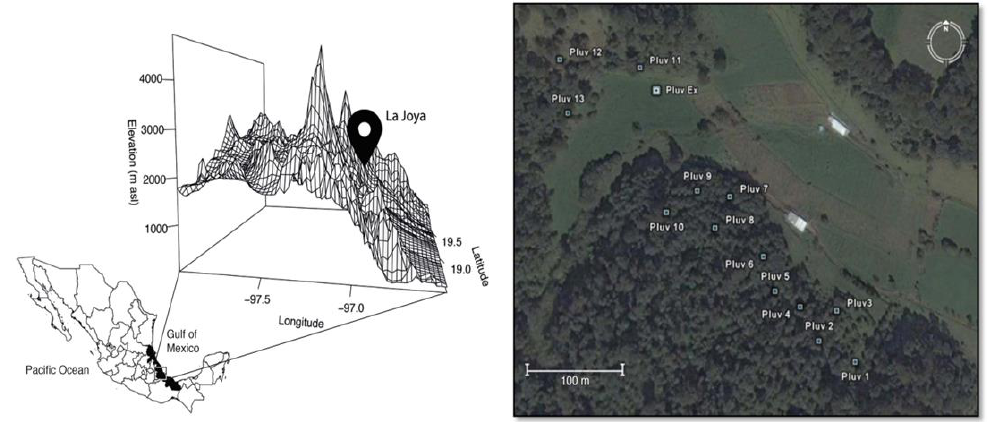
Figure 1. Location of La Joya in the Central Mountainous Region of Veracruz, Mexico, and location of the rain gauges in the study area. The external rain gauge is named “Pluv Ex”.